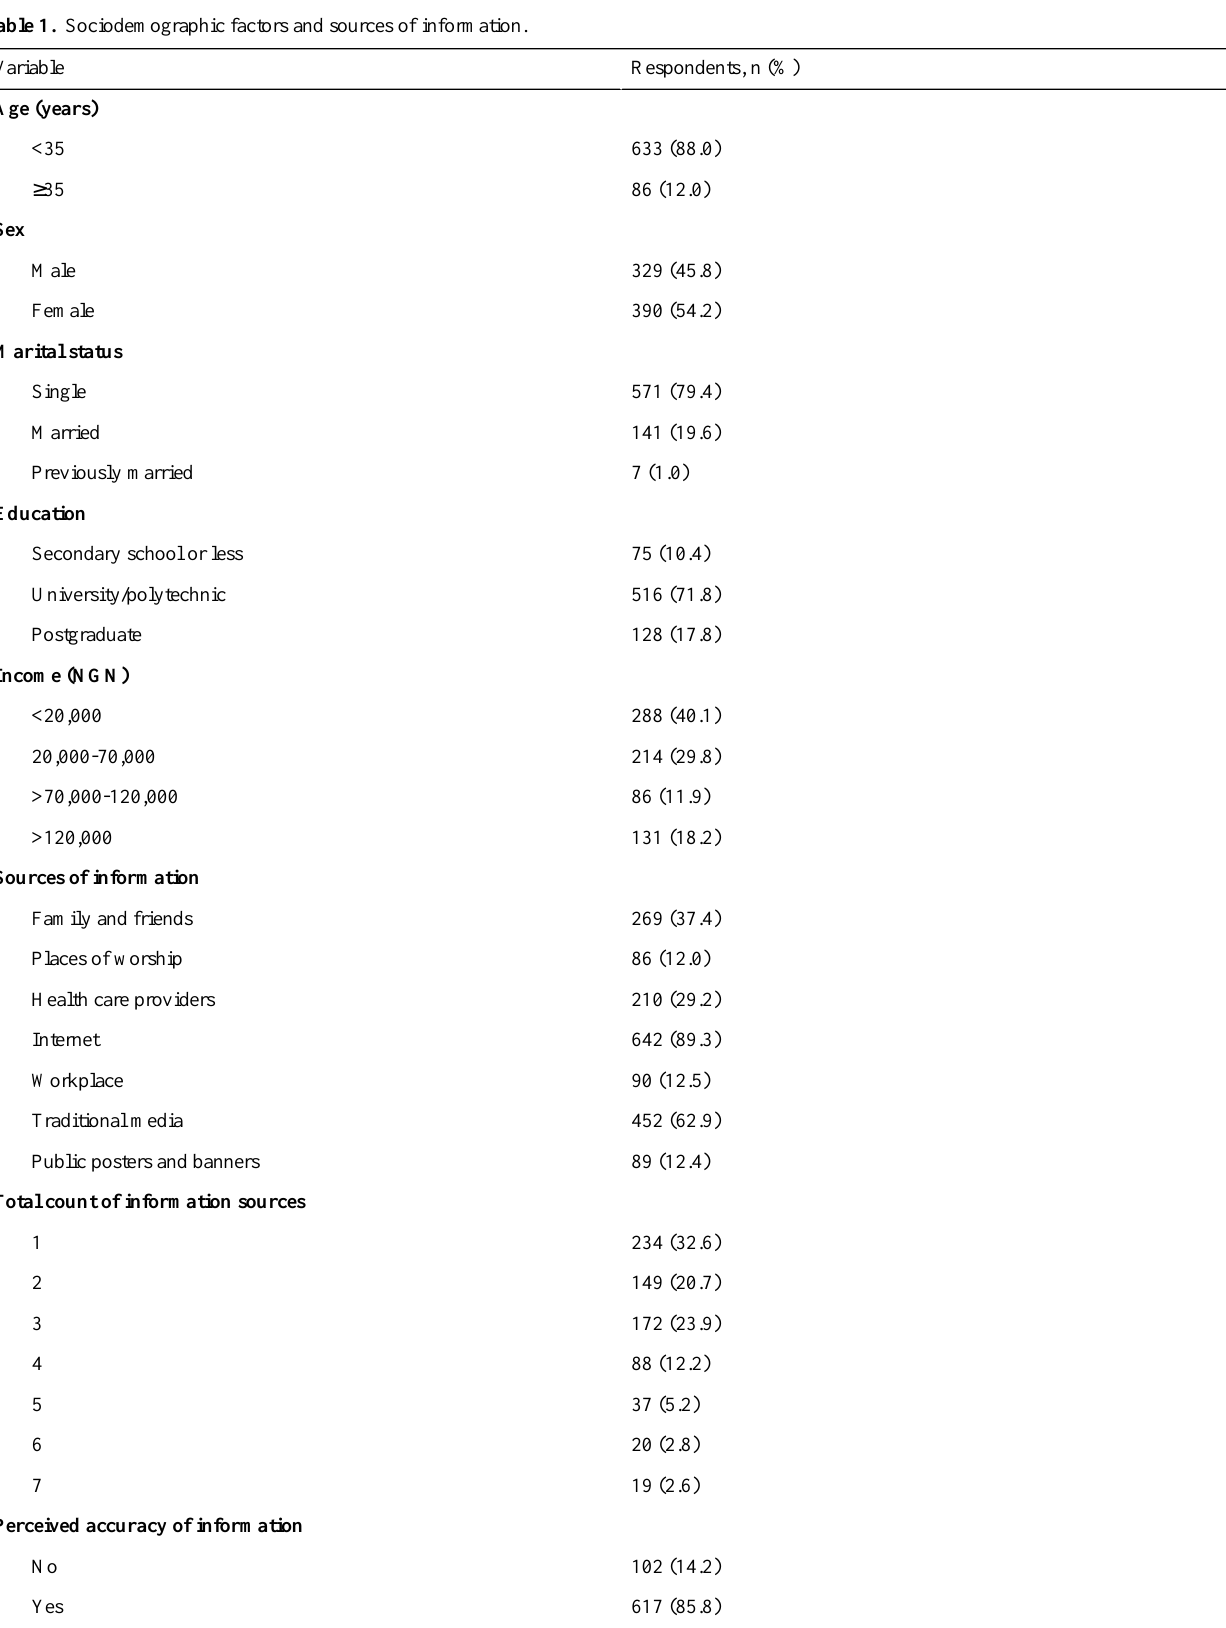
Table 1. Sociodemographic factors and sources of